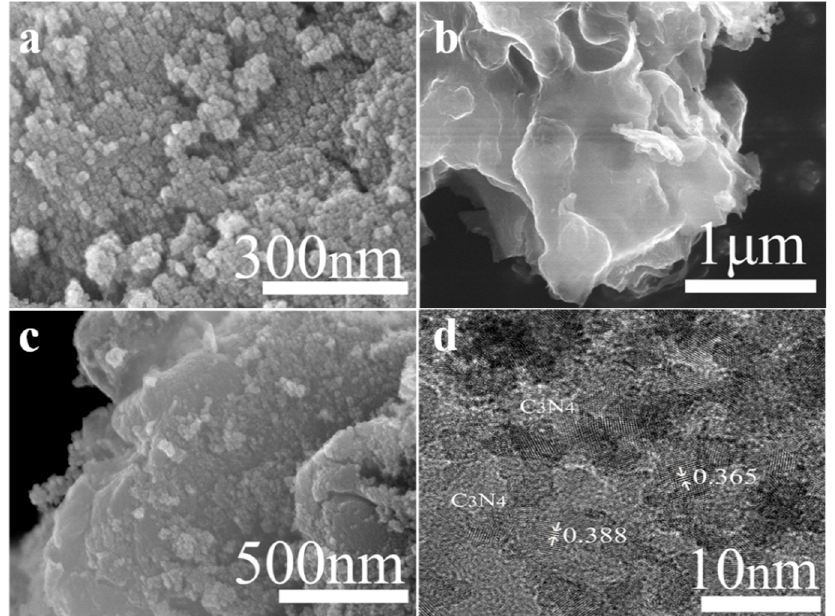
Figure 2. SEM images of La-N-TiO 2 ( a ), g-C 3 N 4 ( b ), CN/La-N-TiO 2 ( c ), and TEM images of CN/La- N-TiO 2 ( d ).